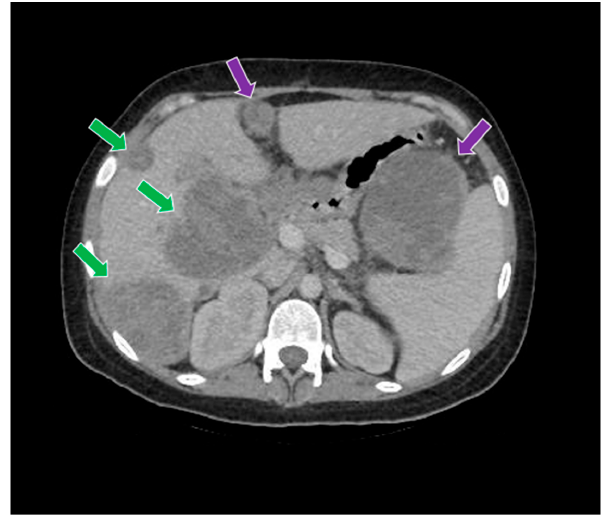
Figure 9. The computed tomography study in the portal phase demonstrates liver metastases (green arrows) and abdominal metastases (purple arrows).